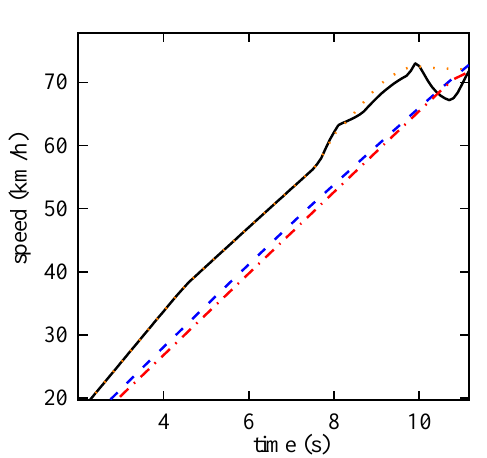
Figure 21. Enlarged view of vehicle speed.